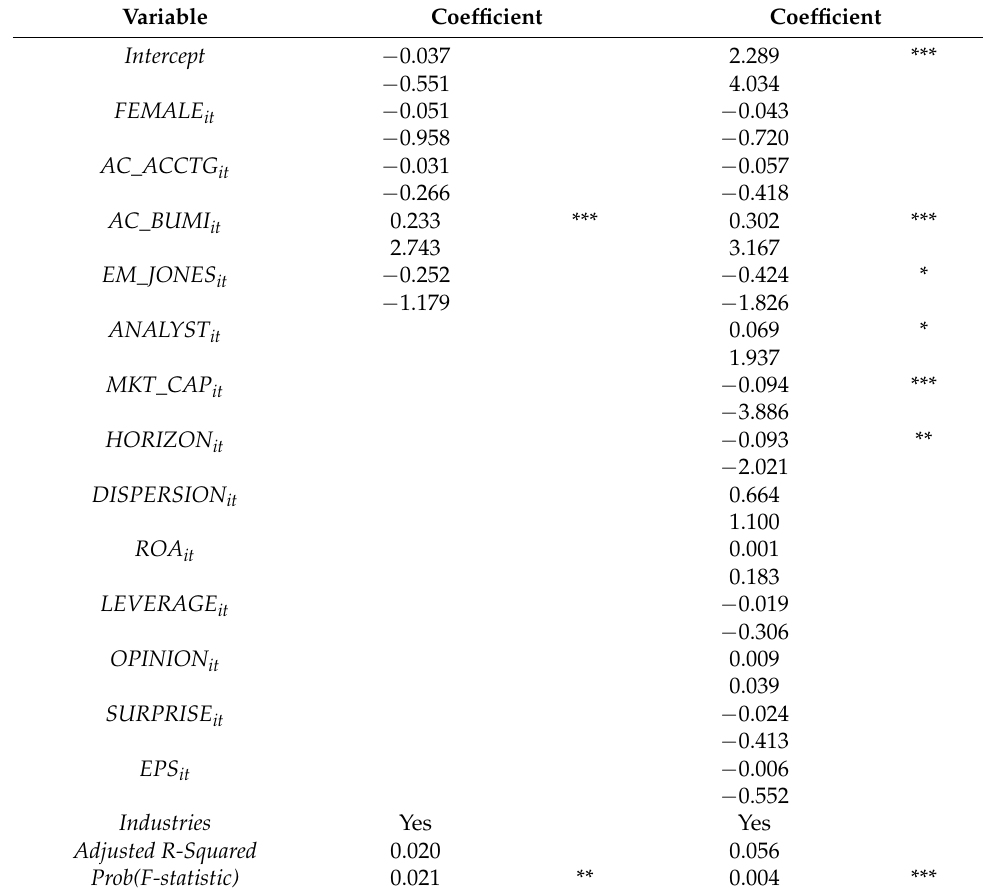
Table 8. Robustness Test: Regression Analysis of Analyst Forecast Accuracy and Audit Committee Diversity using Jones’ (1991) measurement of earnings